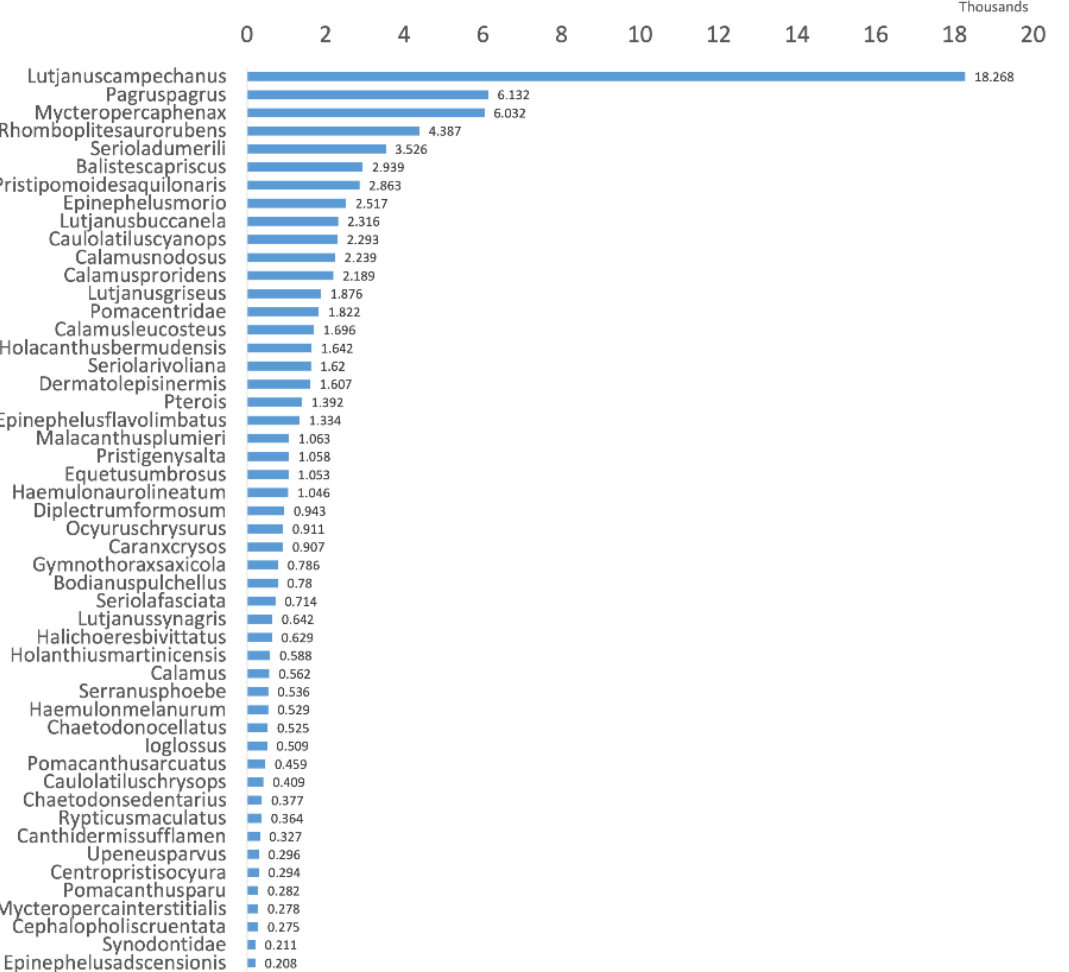
Figure 3. The sample number of occurrences per species distribution in SEAMAPD21 [7] shows a highly imbalanced